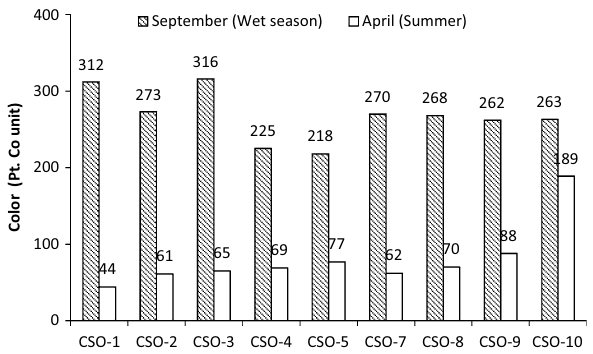
Fig. 11 Variation of color (Pt. Co unit) at all 9 sampling locations close to the CSO structures in September (Wet season) and April (Summer)